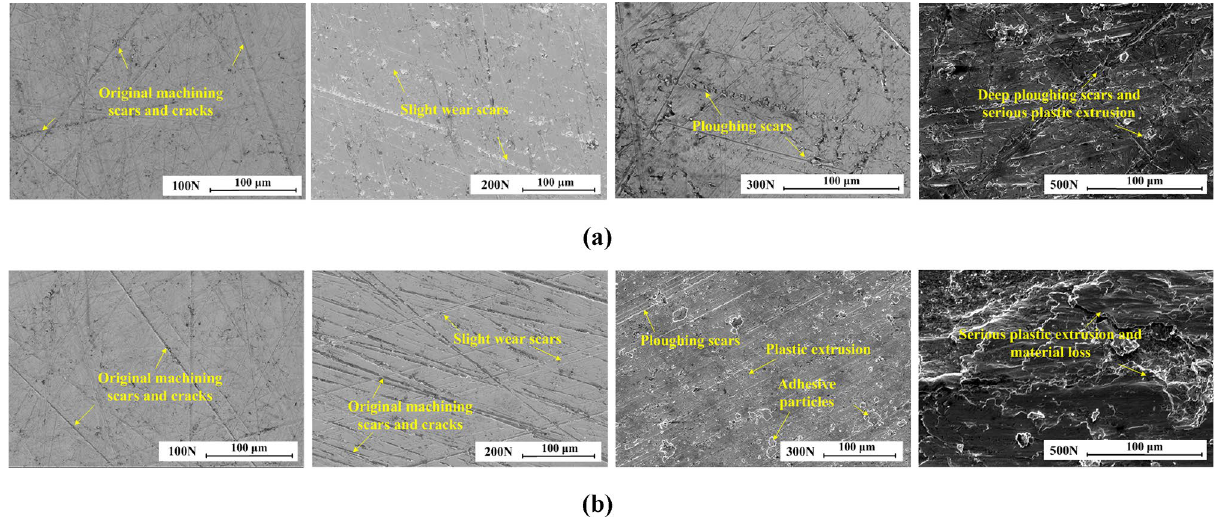
Figure 7. Wear topographies of bottom specimens versus the smooth upper specimens: ( a ) under rich-oil lubrication condition; ( b ) under poor-oil lubrication